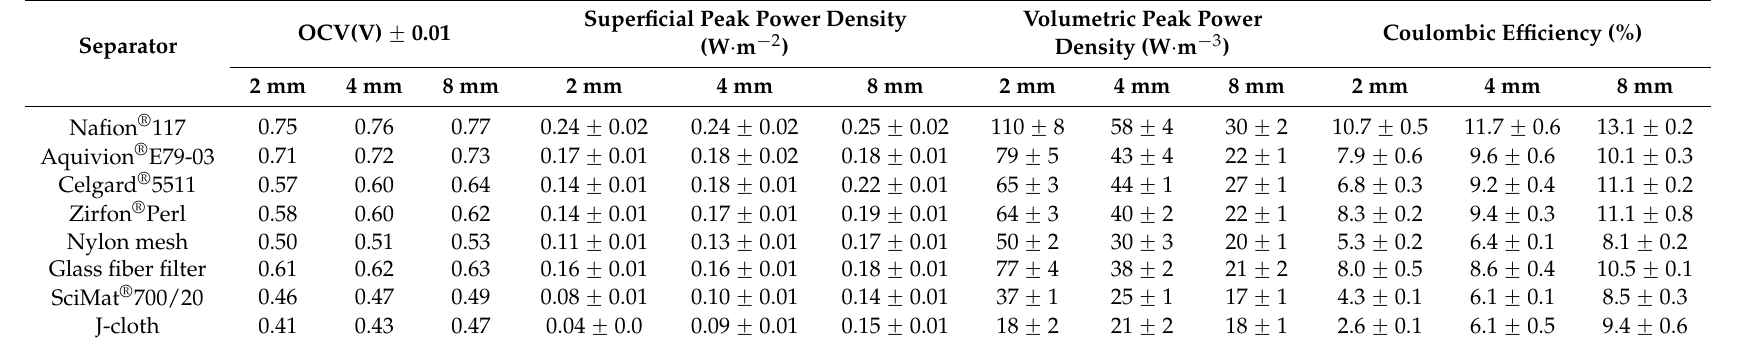
Table 3. Performance characteristics of the 2 mm, 4 mm, and 8 mm FPMFCs with the selected